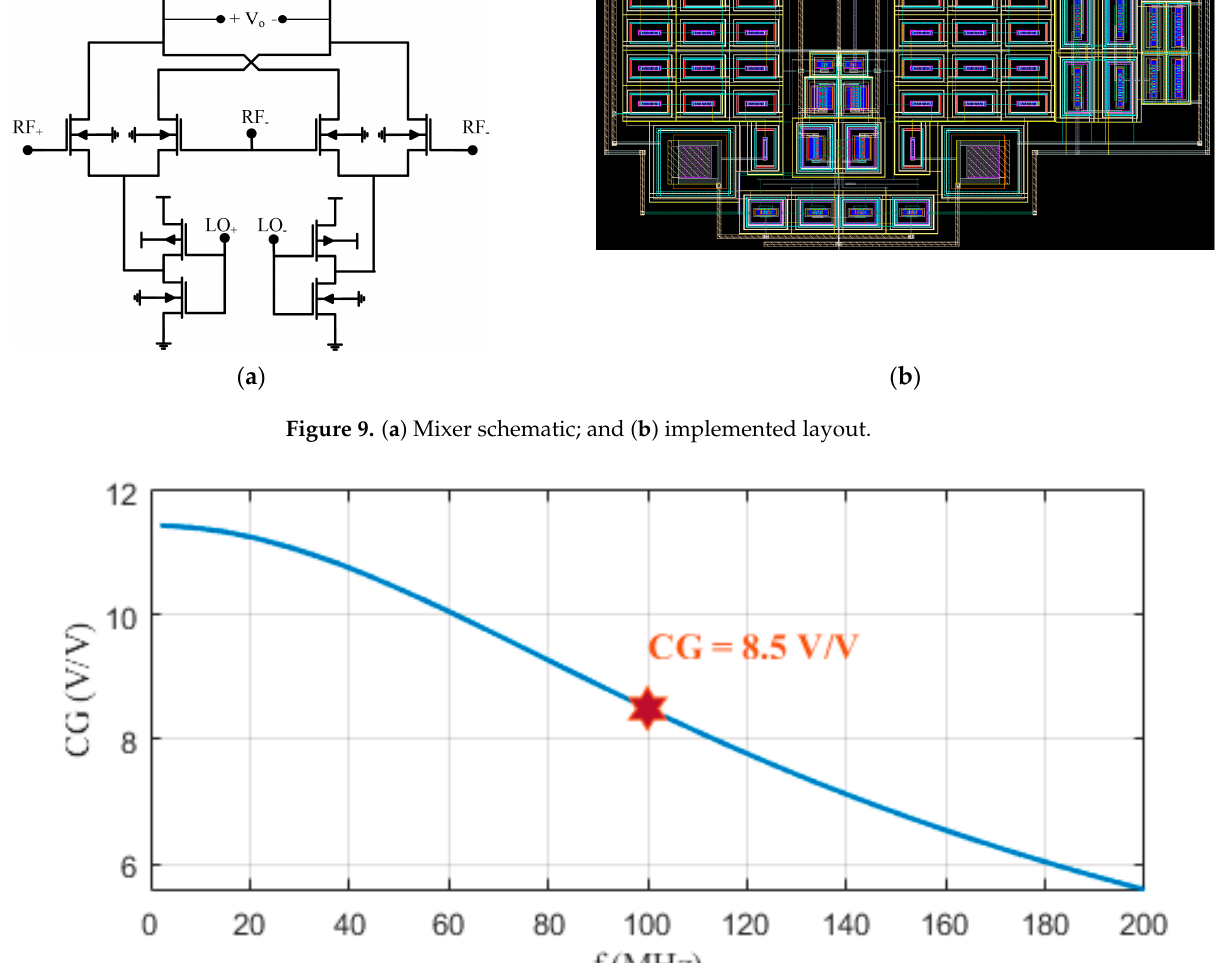
Figure 11. ( a ) LPF schematic [30]. ( b ) Layout of the BPF.